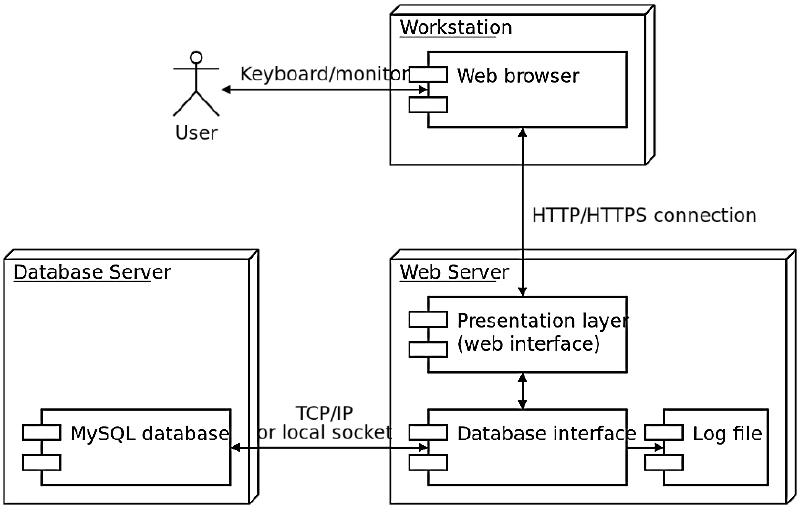
Figure 6. Deployment diagram.